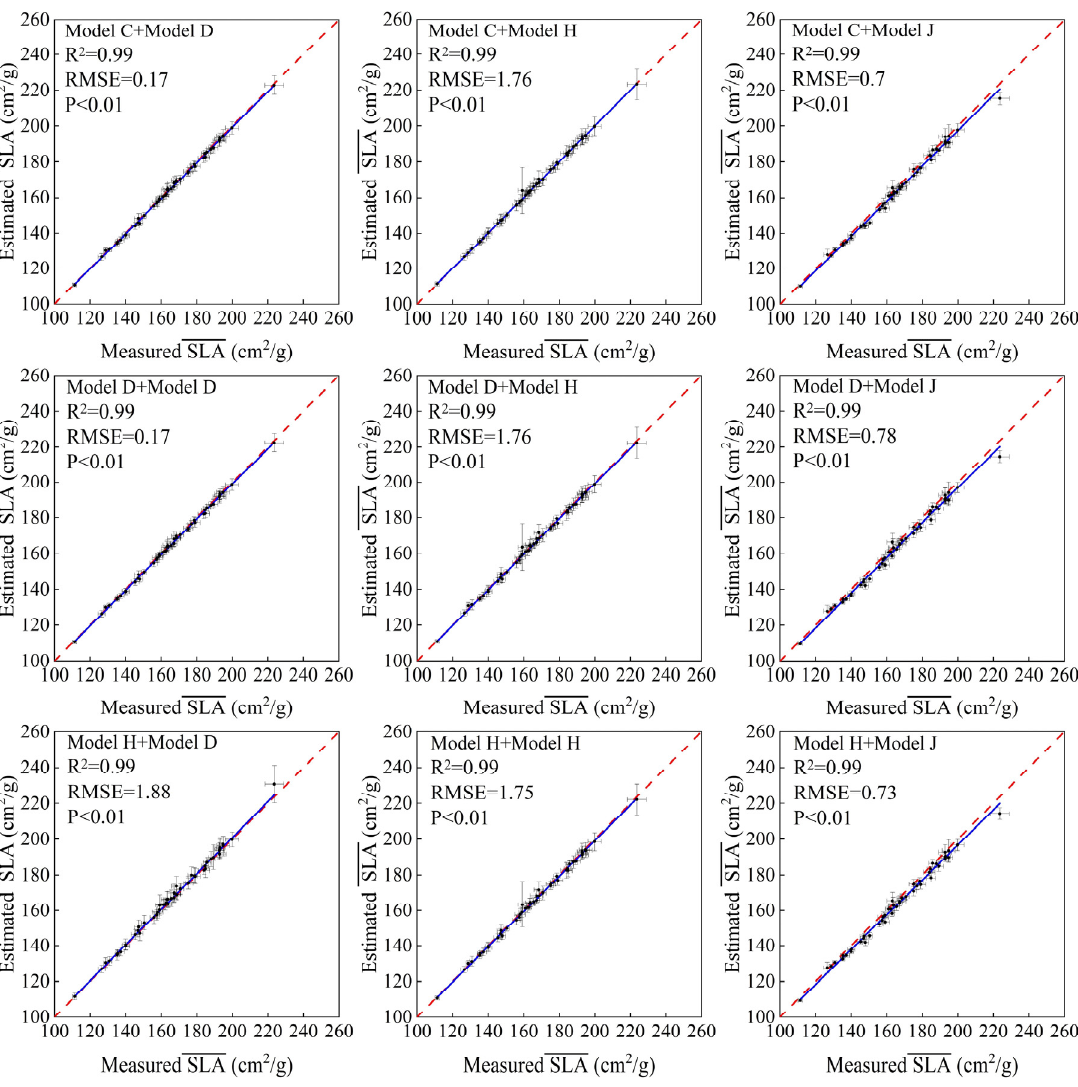
Figure 5. Validation of estimated SLAs of the 50 bamboo species. Black spots represent the mean value of SLA, and error bars are the standard deviation of SLA based on 40 model repetitions.